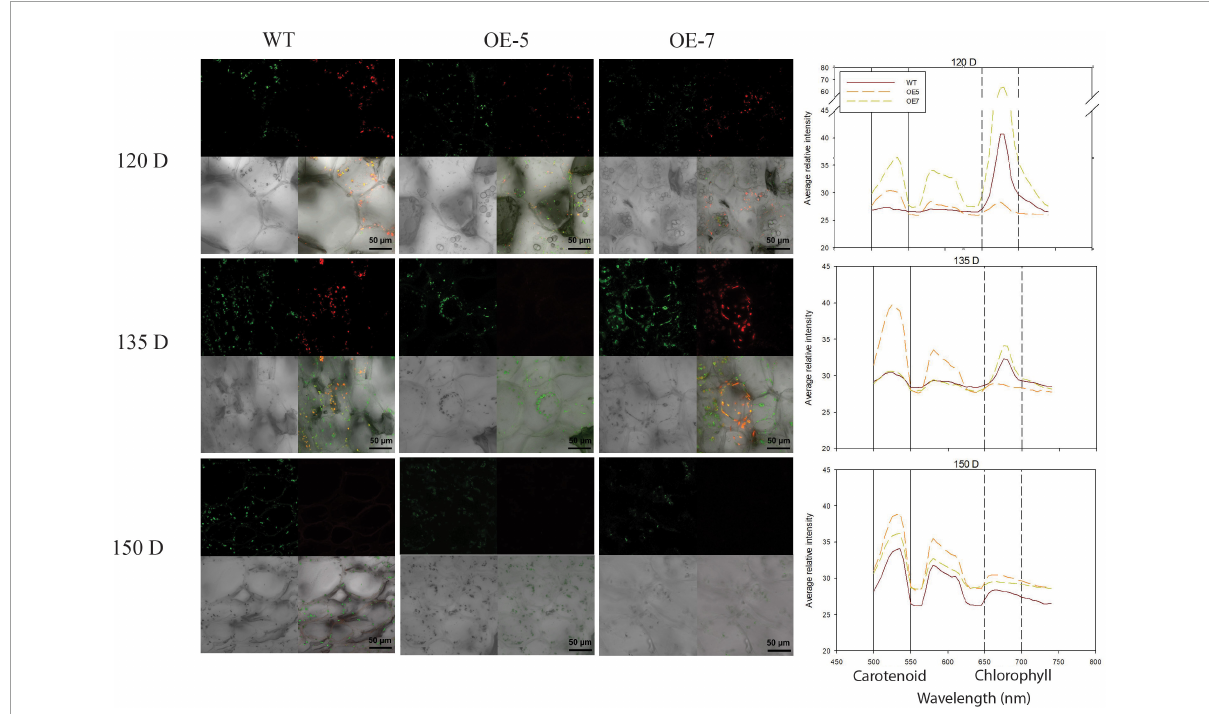
FIGURE2 Visualization of chlorophyll and carotenoid autofluorescence in wild type (WT) and PSY ‘Royal Gala’ fruit. Fresh fruit tissues, at 120, 135, and 150 D, were analyzed by confocal microscopy to show plastids containing chlorophyll (red), carotenoid (green) and both pigments (yellow). Graph represents fluorescence emission spectra of WT and PSY transgenic tissue. Fluorescence emission between 500 and 600 nm represents carotenoids and 650–750, chlorophyll